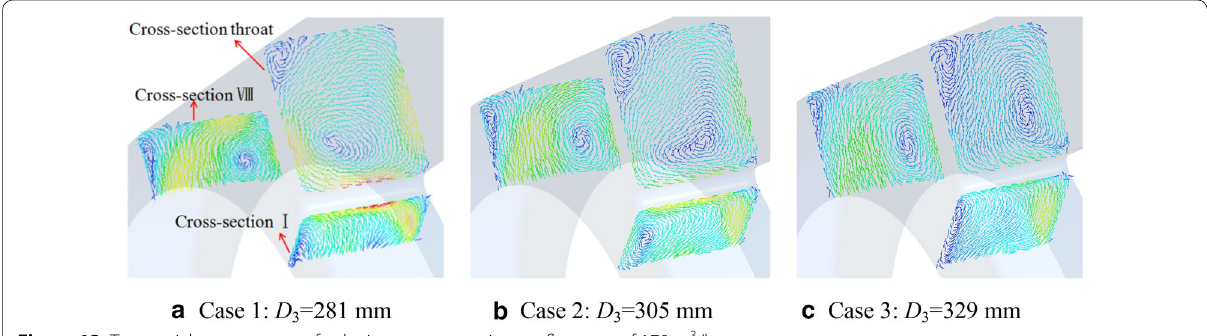
Figure 13 Tangential components of velocity at cross-sections at flow rate of 170 m 3